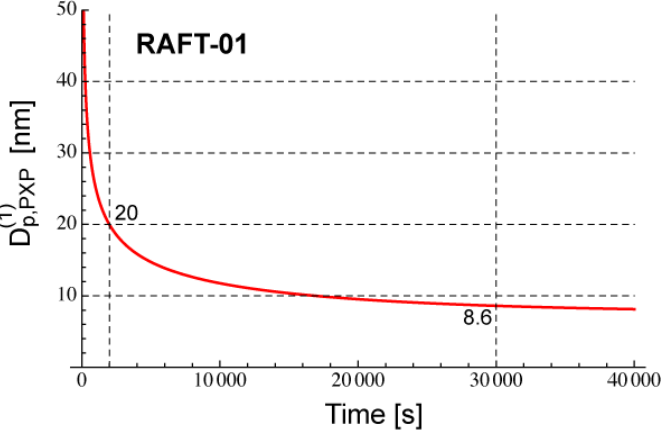
Figure 9. Calculated time development of the (cid:1830) (cid:2926),PXP(cid:4666)(cid:2869)(cid:4667) -values for